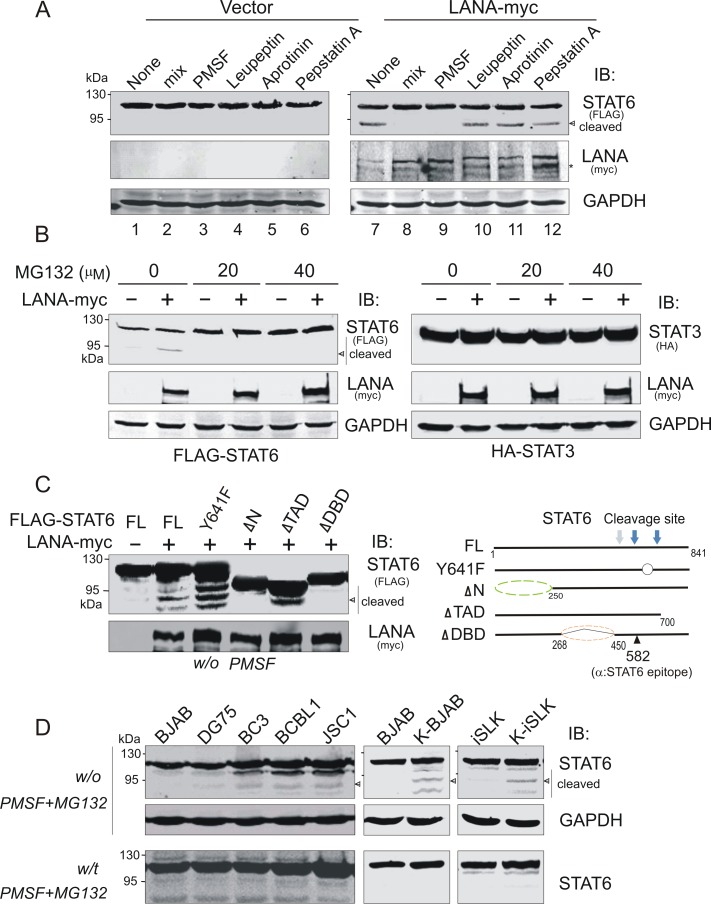
STAT6 is cleaved by serine protease upon KSHV infection.(A) LANA promotes serine protease-mediated cleavage of STAT6. HEK293 cells co-transfected by FLAG-STAT6 with LANA-myc or vector alone were lysed in the absence or presence of different protease inhibitors as indicated, followed by immunoblotting against exogenous STAT6, LANA or GAPDH. Asterisk indicates the cleaved bands of LANA. (B) LANA-induced STAT6 cleavage is also MG132 sensitive. HEK293 cells were co-transfected by FLAG-STAT6 with LANA-myc or vector alone. At 48hr post-transfection, cells were treated with different dosages of proteasomal inhibitor MG132 for 2hr before harvest, and lysed in the absence of PMSF (serine-protease inhibitor) followed by immunoblotting against exogenous STAT6, LANA or GAPDH. HA-STAT3 was used as a parallel control. (C) LANA-induced STAT6 cleavage depends on its interacting domain but not Y641 phosphorylation. HEK293 cells co-transfected by LANA-myc with full length FLAG-STAT6 or its mutants were lysed in the absence of PMSF, followed by immunoblotting against exogenous STAT6 or LANA. The potential cleavage sites of STAT6 induced by LANA are proposed based on the molecular weight of cleaved isoforms and indicated on the right panel. (D) Higher levels of STAT6 cleavage in KSHV-positive cells than that in KSHV-negative cells. Cell lysates in the presence or absence of PMSF and MG132 treatment were individually subjected to immunoblotting against STAT6 and GAPDH. Arrow indicates the major band of cleaved STAT6 induced by KSHV or LANA.